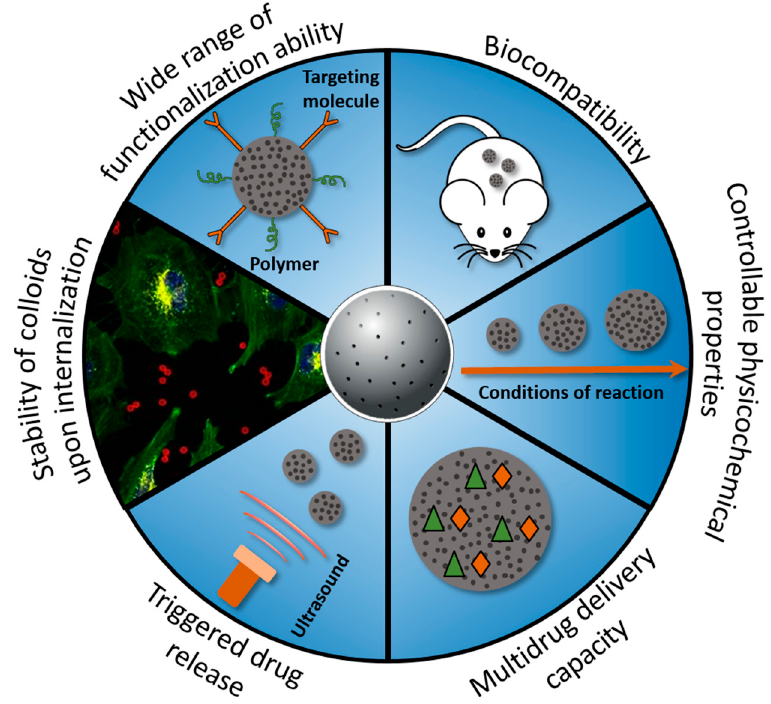
Figure 1. Schematic overview of some advantages of porous carriers for the drug delivery applications.